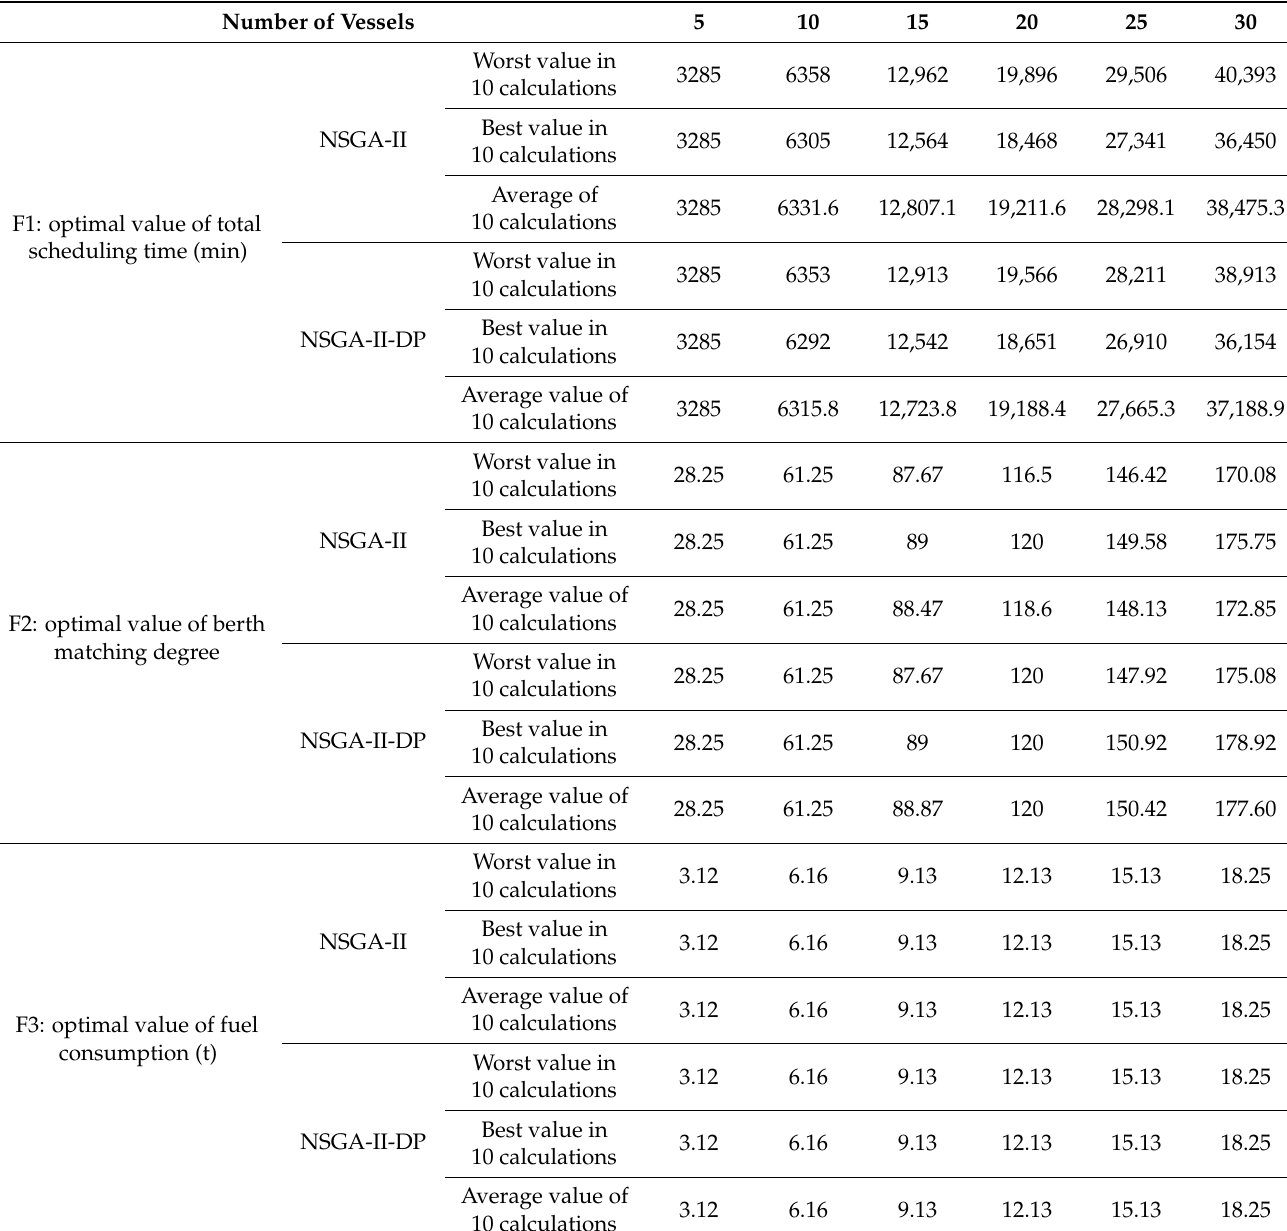
Table 12. The optimal values of the three targets calculated for different numbers of vessels. The results are based on running the algorithms 10 times in each